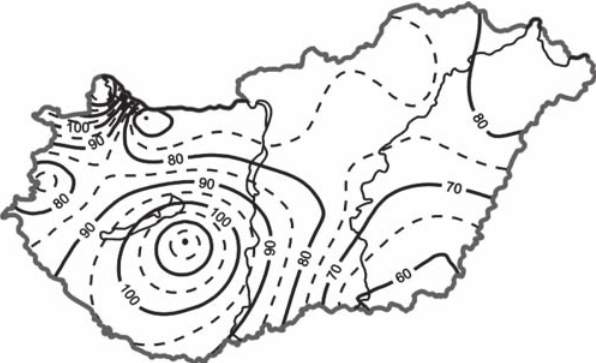
Figure 2 – The absolute daily maxima of precipitation in summer over 16 meteorological stations during the period of 1951–2010 the surrounding of Budapest (Figure 3). High daily maxima occur in the autumn around the SW corner (cca. 100 mm) or NE Hungary (more than 80 mm). The lowest daily maxima occur in the autumn around the SE corner. region, and in the northern part of the Great Plain, the highest maxima (more than 40 mm), whereas the lowest daily maxima (less than 30 mm) were found in the Danube–Tisza region (Figure 4).